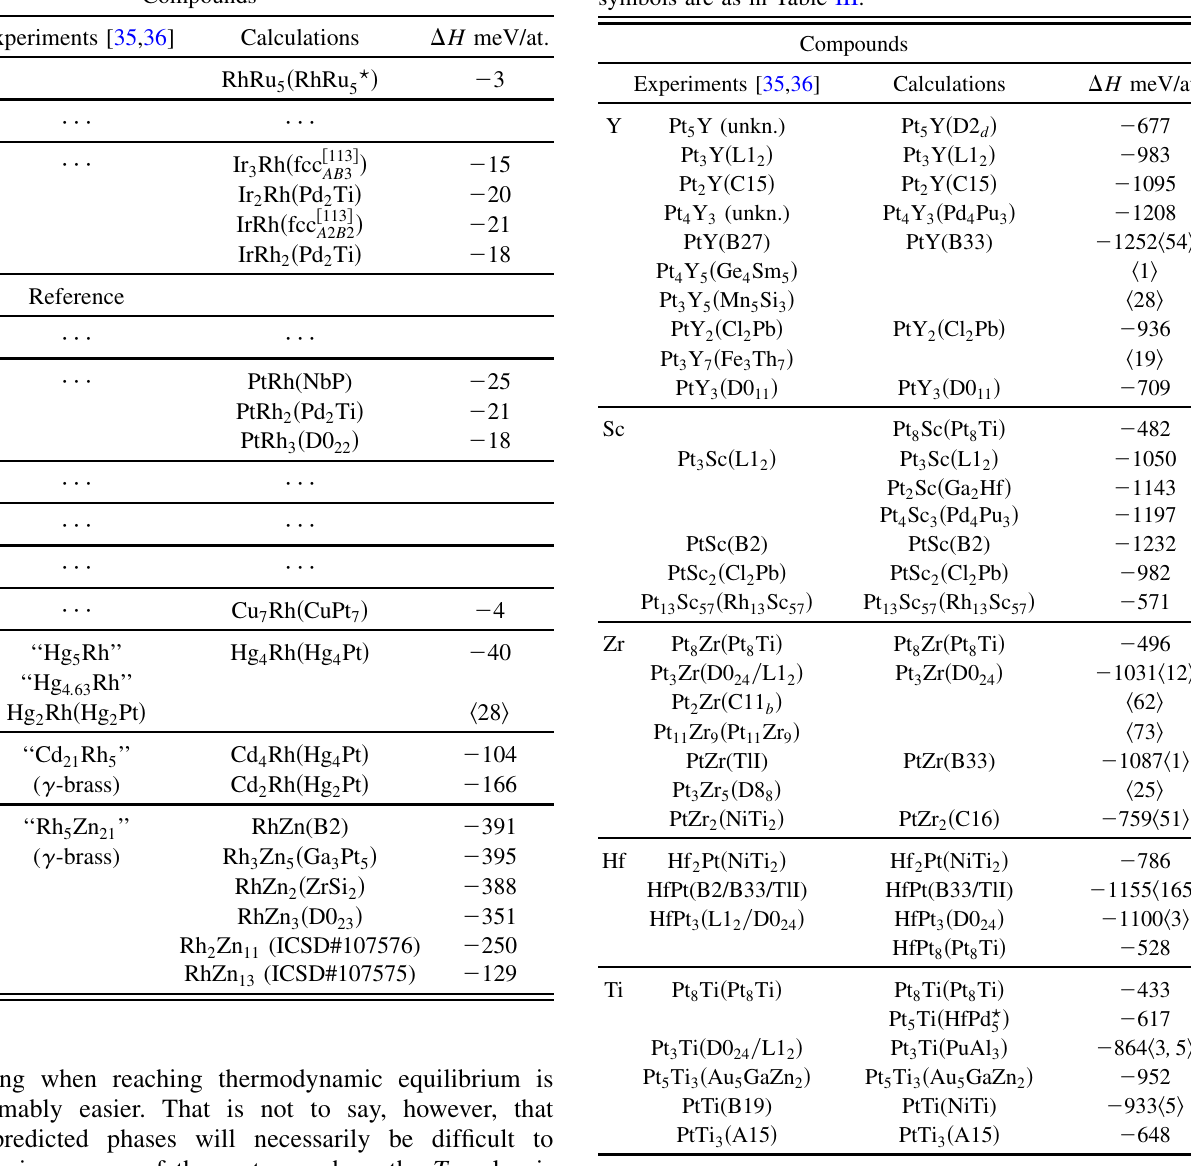
TABLE V. Compounds in Platinum binary alloys. The term denotes a tetragonal distortion of the L1 tet- L1 2 symbols are as in Table